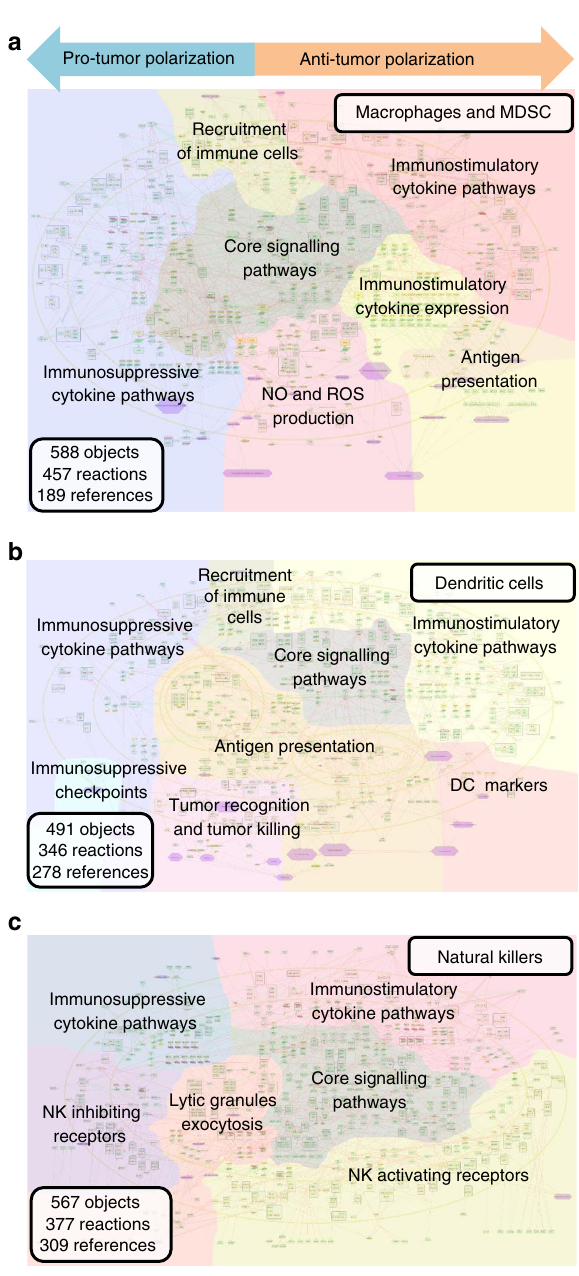
Fig. 2 Cell-type-speci fi c maps. Cell-type-speci fi c networks are visualized at the top-level view, the colorful background indicates boundaries of functional modules of the maps. a The maps of macrophages and MDSC. b The map of dendritic cells. c The map of natural killer